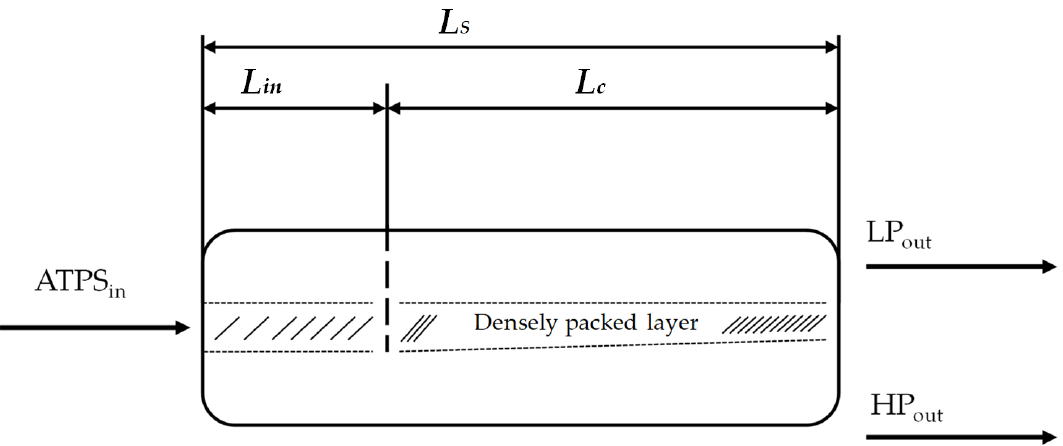
Figure 5. Structure of the settler unit [38]. ATPS: Aqueous two-phase system. L S : Length of the separator. L in : Inlet length. L c : Coalescence length.